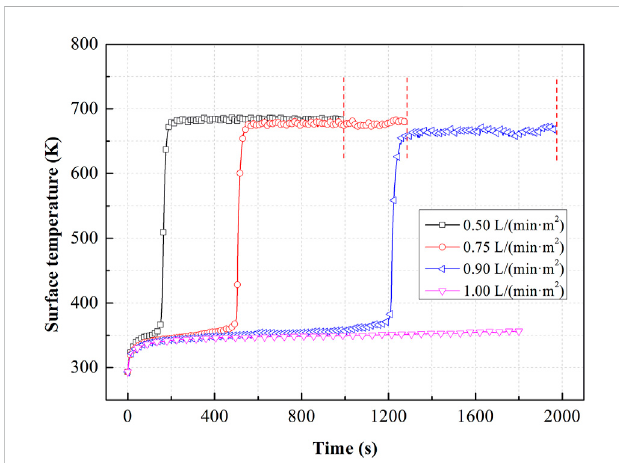
FIGURE 6 Surface temperature of test No. 2 at different water mist fl ow rates under radiant heat fl ux 50 kW/m 2 .